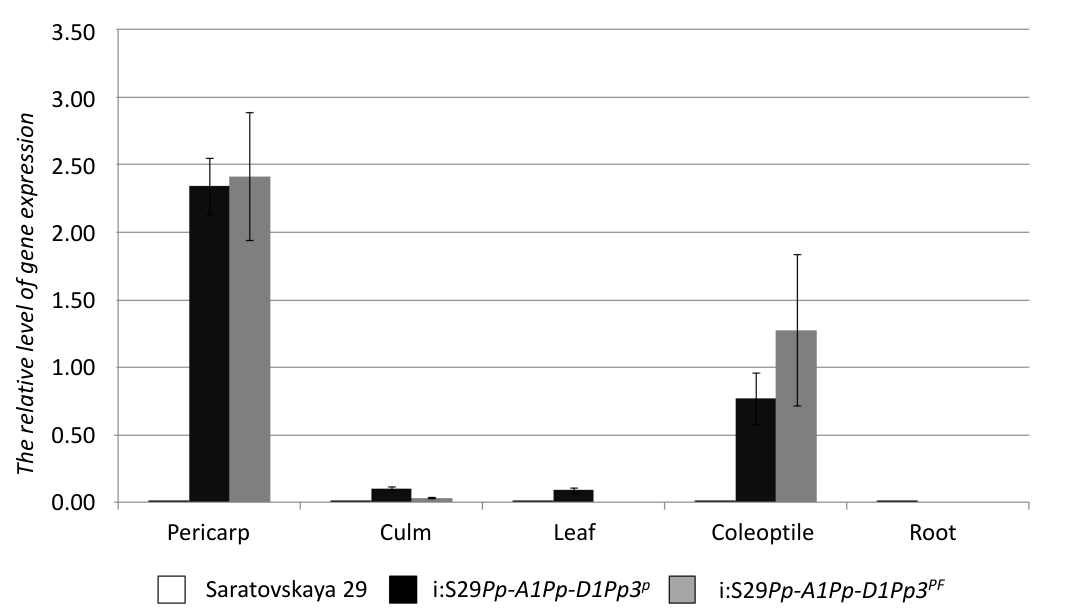
Figure 4. Transcription of TaMyc1 in various parts of the wheat plant. Statistical analysis of transcript abundances given in Supplementary Table